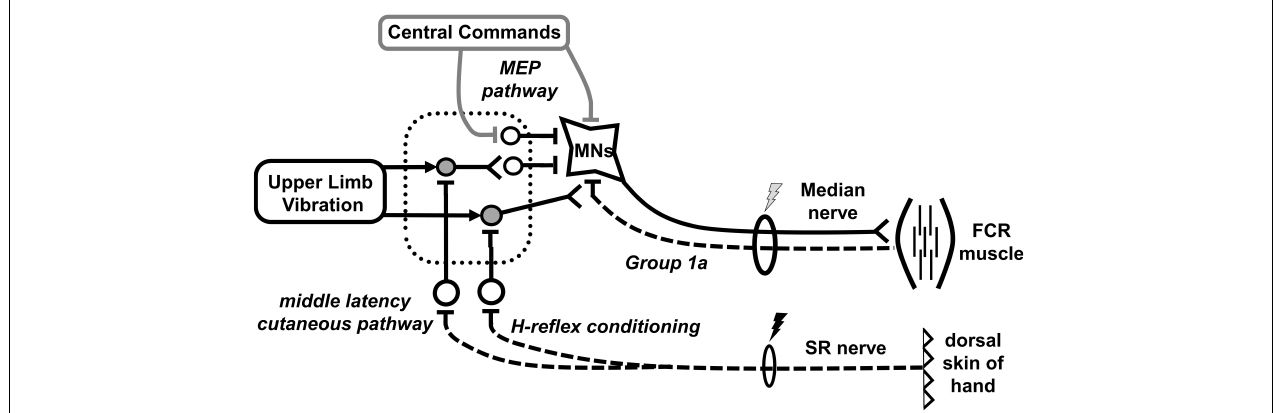
FIGURE 3 | Schematic diagram outlining likely neural pathways for integration of inputs from indirect vibration applied to the upper limb (ULV). It remains likely that ULV has both pre- and post-synaptic effects on spinal excitability without altering cortico-spinal excitability. The mechanism of H-reflex conditioning with superficial radial (SR) nerve stimulation reducing pre-synaptic inhibition of the FCR Ia afferent is highlighted. Primary afferents are displayed with dashed lines. Excitatory synapses are displayed as a “T” with open cell bodies while inhibitory synapses are displayed with a “V” and gray cell bodies. The dotted rectangle represents a network of interneurons within the spinal